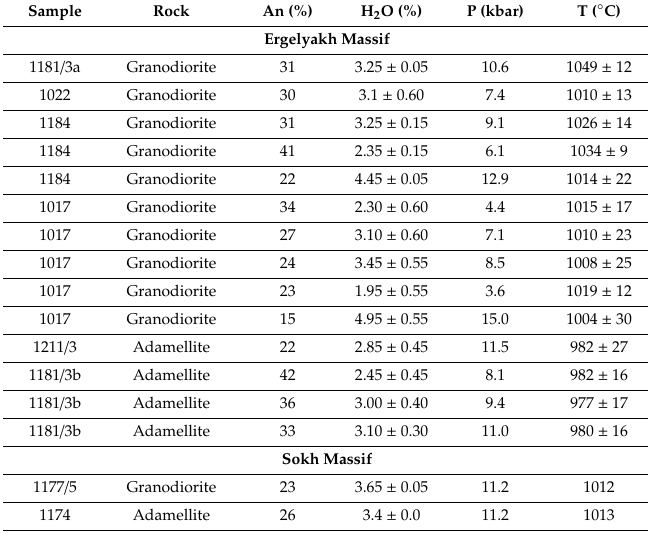
Table 10. Plagioclase–liquidus equilibrium parameters of formation of EIRGD granitoids.